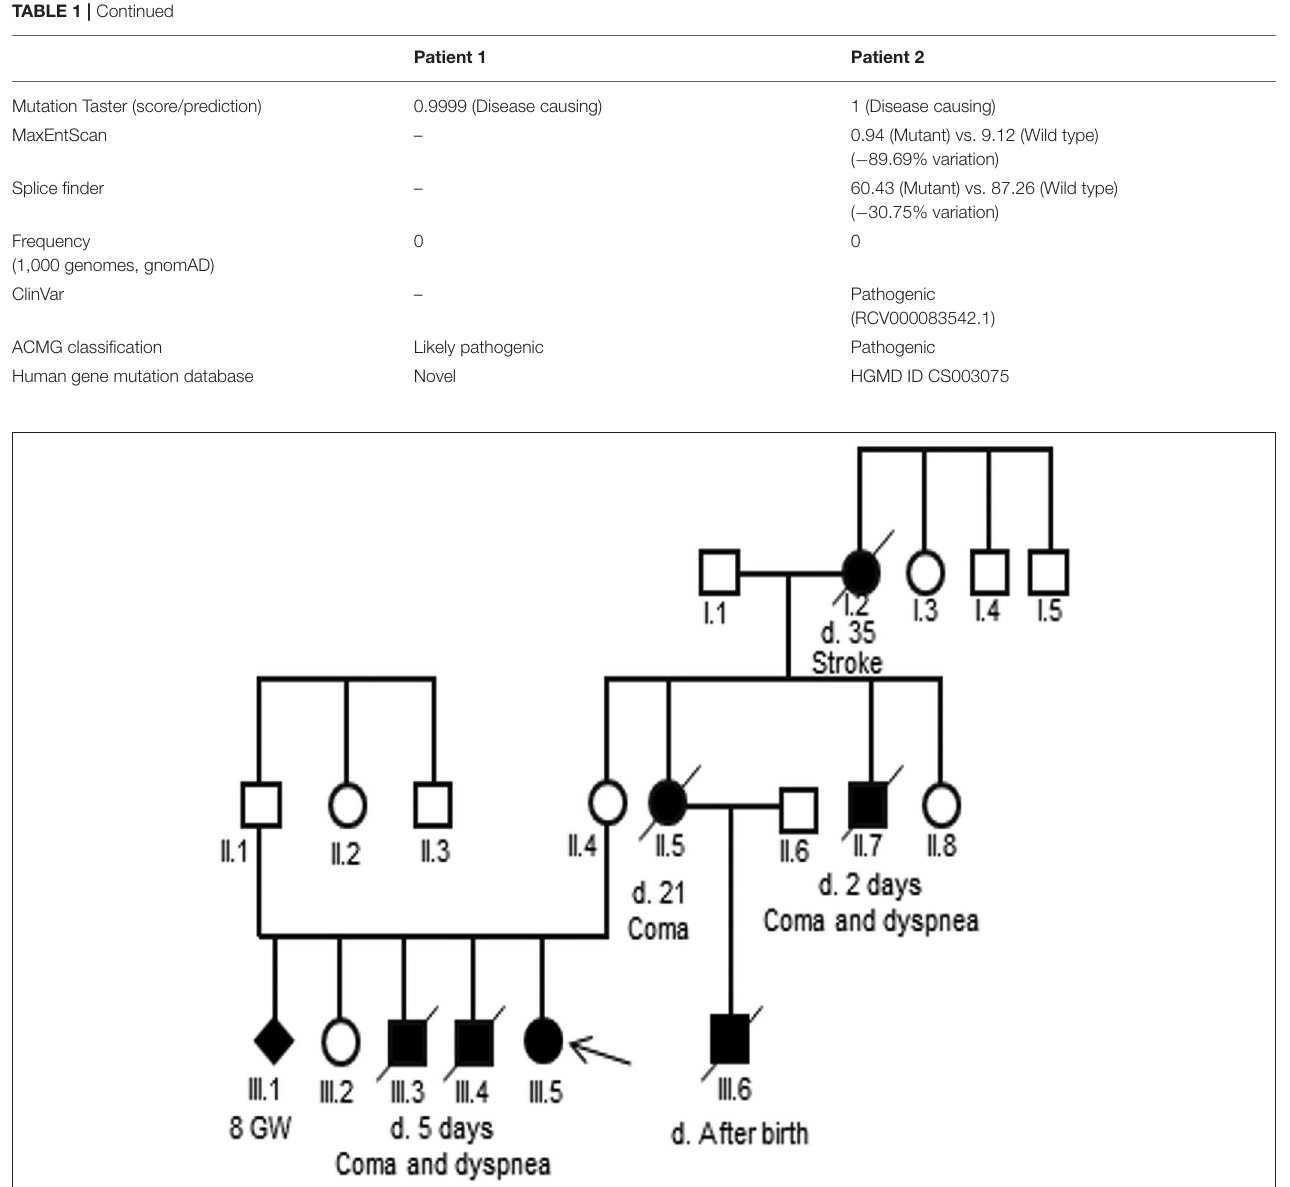
FIGURE 1 | Pedigree of the three-generation family of the patient 2. Generations are shown as I to III. Males are indicated by squares, females by circles, affected members by a shaded black square or circles and the proband by an arrow. Shaded black square with slash indicates death.